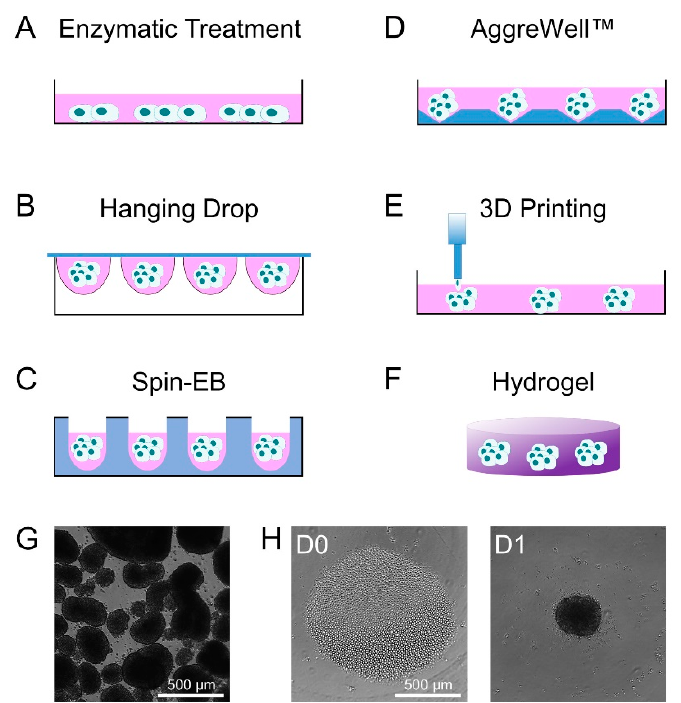
Figure 1. Schematic representation of commonly used methods for the formation of embryoid bodies. ( A ) EBs are commonly produced from monolayer cultures of pluripotent stem cells using enzymatic treatment to fragment and detach cell colonies from the culture well. ( B ) Seeding single pluripotent stem cells in hanging drops facilitates the generation of homogeneous EBs. Alternatively, single cells can be spun down in ( C ) U-shaped bottom wells or ( D ) AggreWells TM to facilitate homogeneous cell aggregation. ( E ) Bioprinting using cell-laden biological ink allows better control over the composition of EBs. Finally, ( F ) hydrogels provide an elastic 3D environment which allows the spontaneous formation and differentiation of EBs. ( G ) Exemplary phase contrast images of EBs produced by enzymatic treatment and ( H ) EBs produced by a Spin-EB assay starting with a specific cell number (D0) to generate aggregates that are more uniform in size (D1).